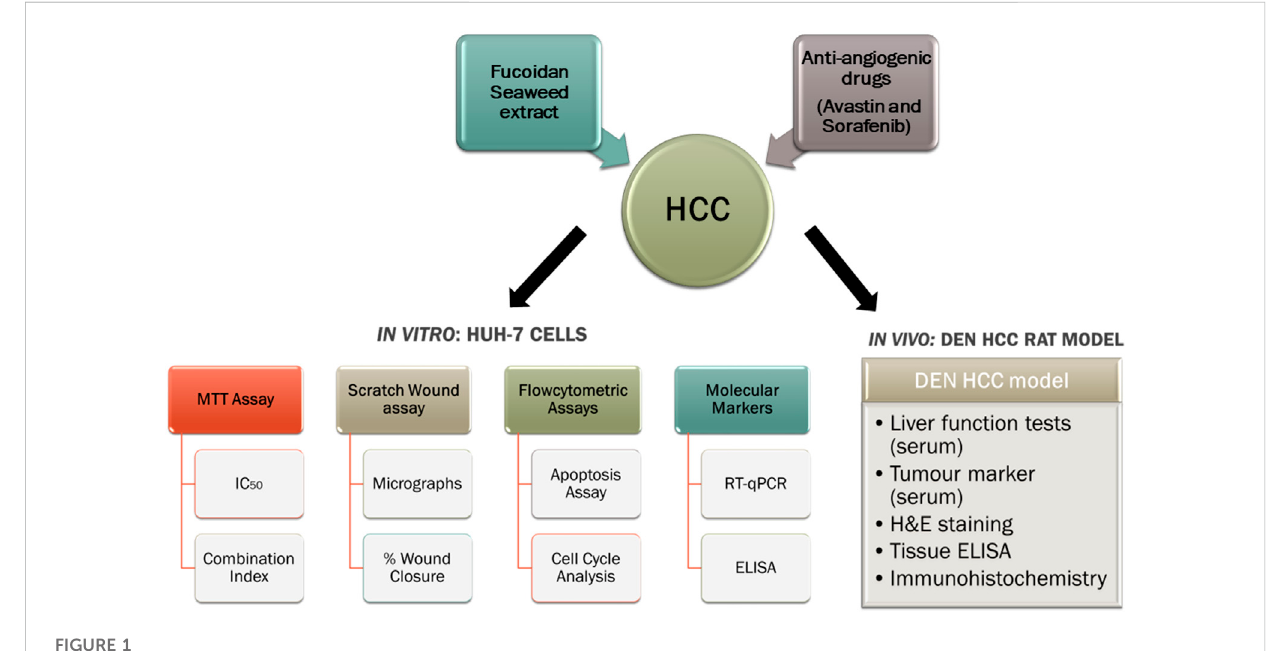
FIGURE 1 A graphical summary of our experimental